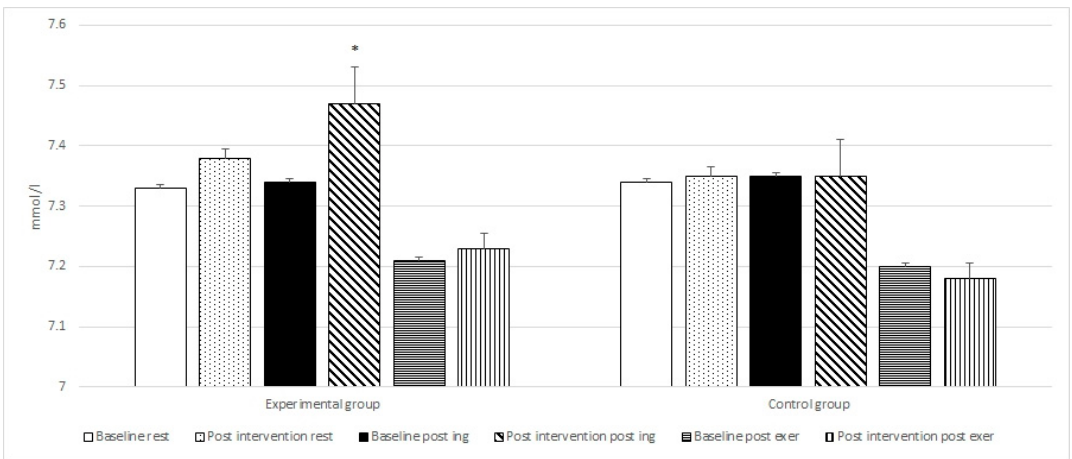
Figure 2. Baseline and post intervention blood pH at rest, post ingestion, and post exercise in the experimental and control groups. * statistically significant.